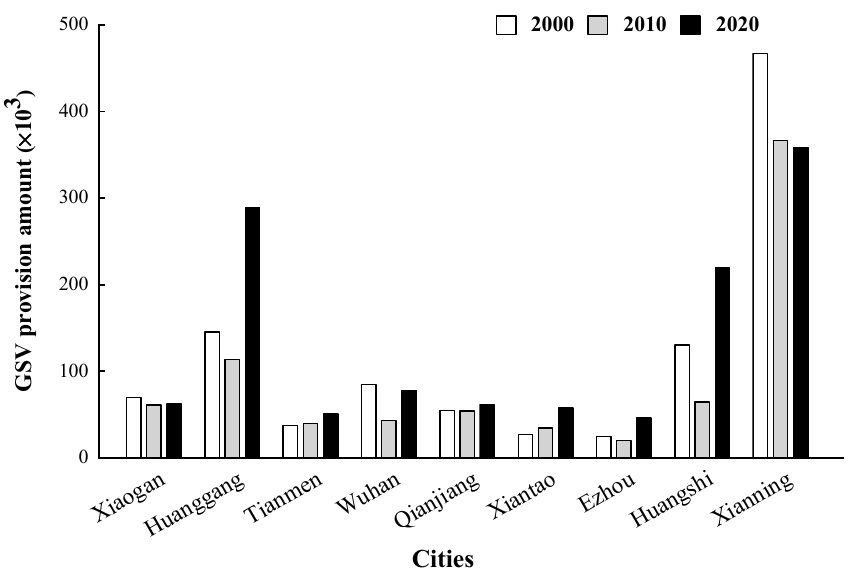
Figure 6. GSV provision on city level of 2000, 2010 and 2020.